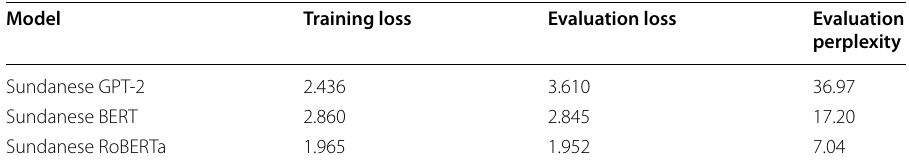
Table 3 Pre-training results of Sundanese language models